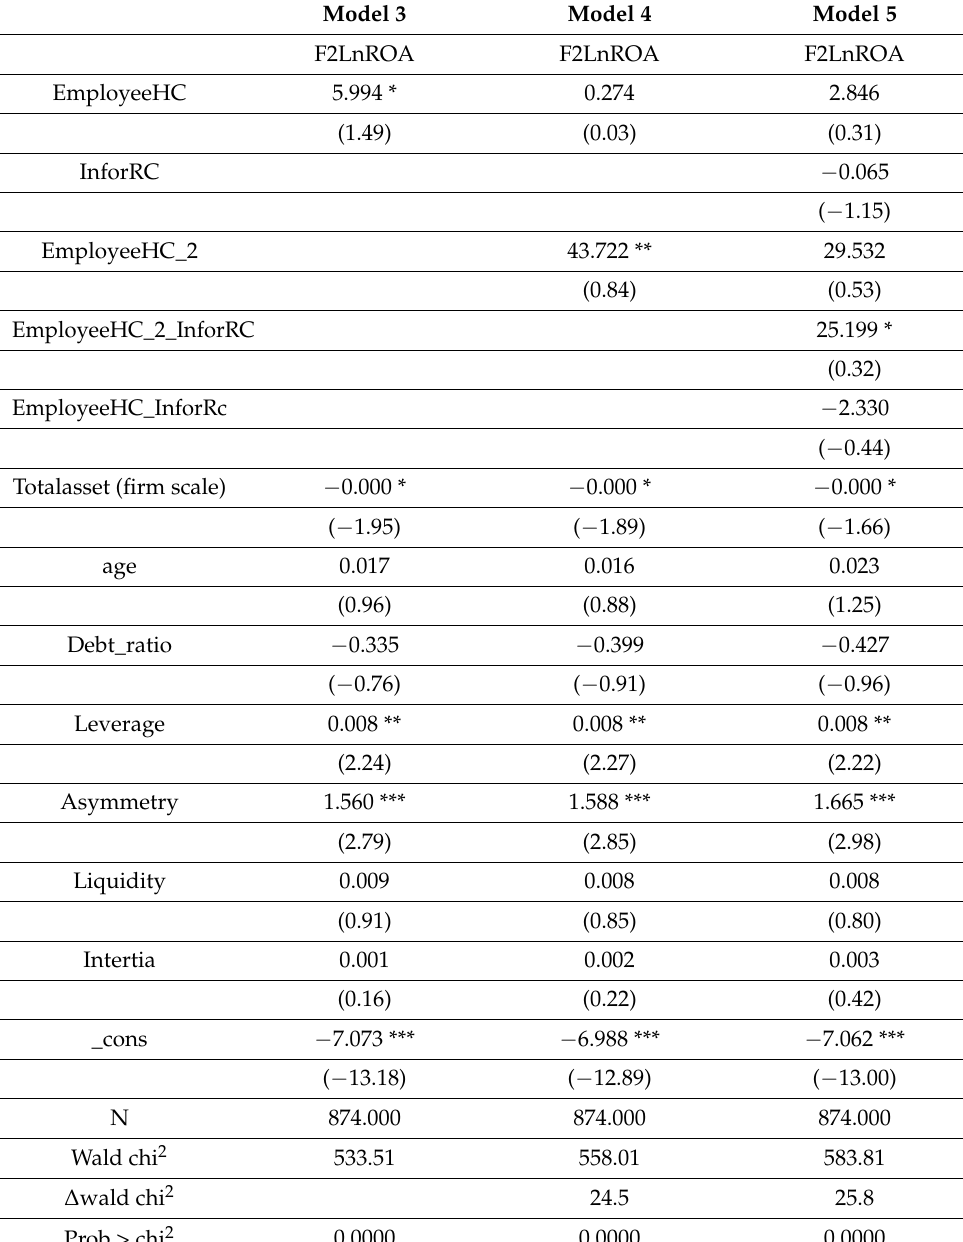
Table A2. Results of the panel regression with random